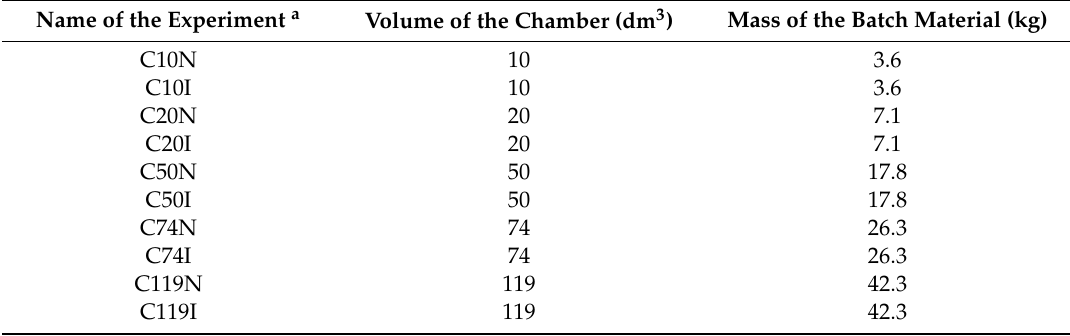
Table 1. Scheme of composting